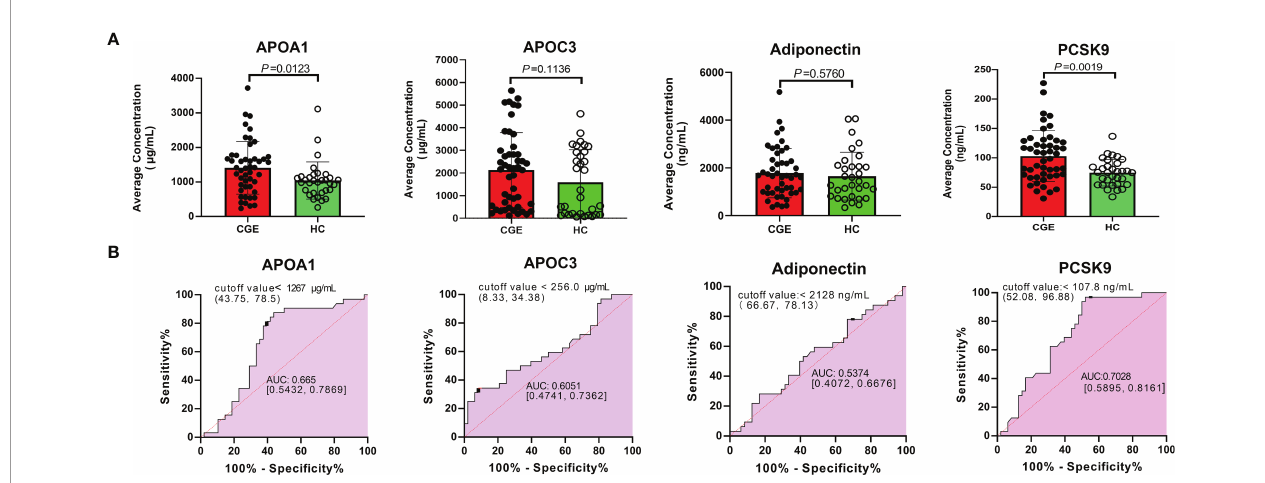
FIGURE 3 | ELISA validation of APOA1, APOC3, Adiponectin and PCSK9 in another cohort. (A) The concentration comparison and (B) ROC analysis of APOA1, APOC3, Adiponectin and PCSK9 between CGE patients and healthy controls.